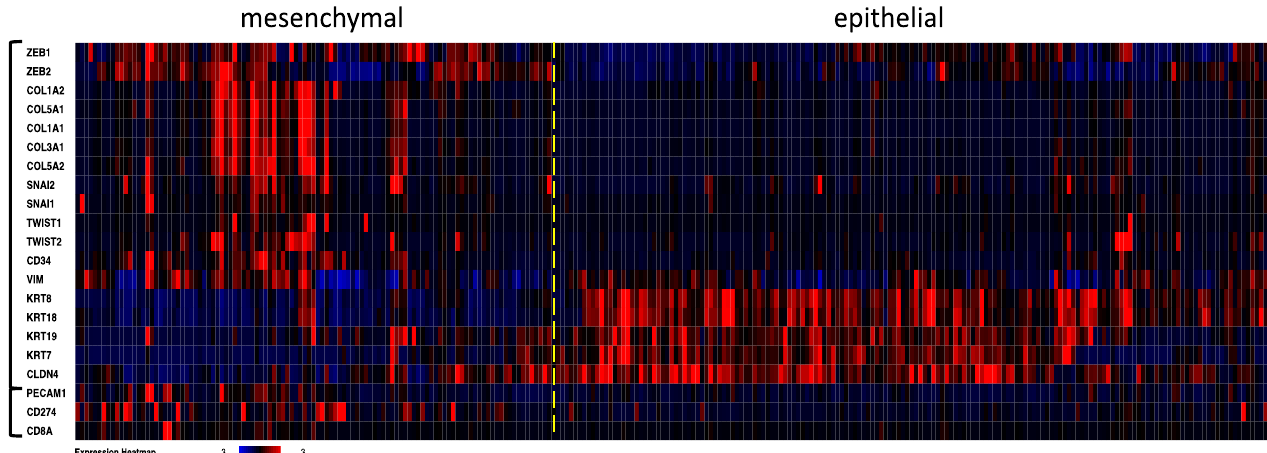
Figure 3. Transcriptome investigation in 512 clear cell RCC cases from TCGA (PanCancer Atlas